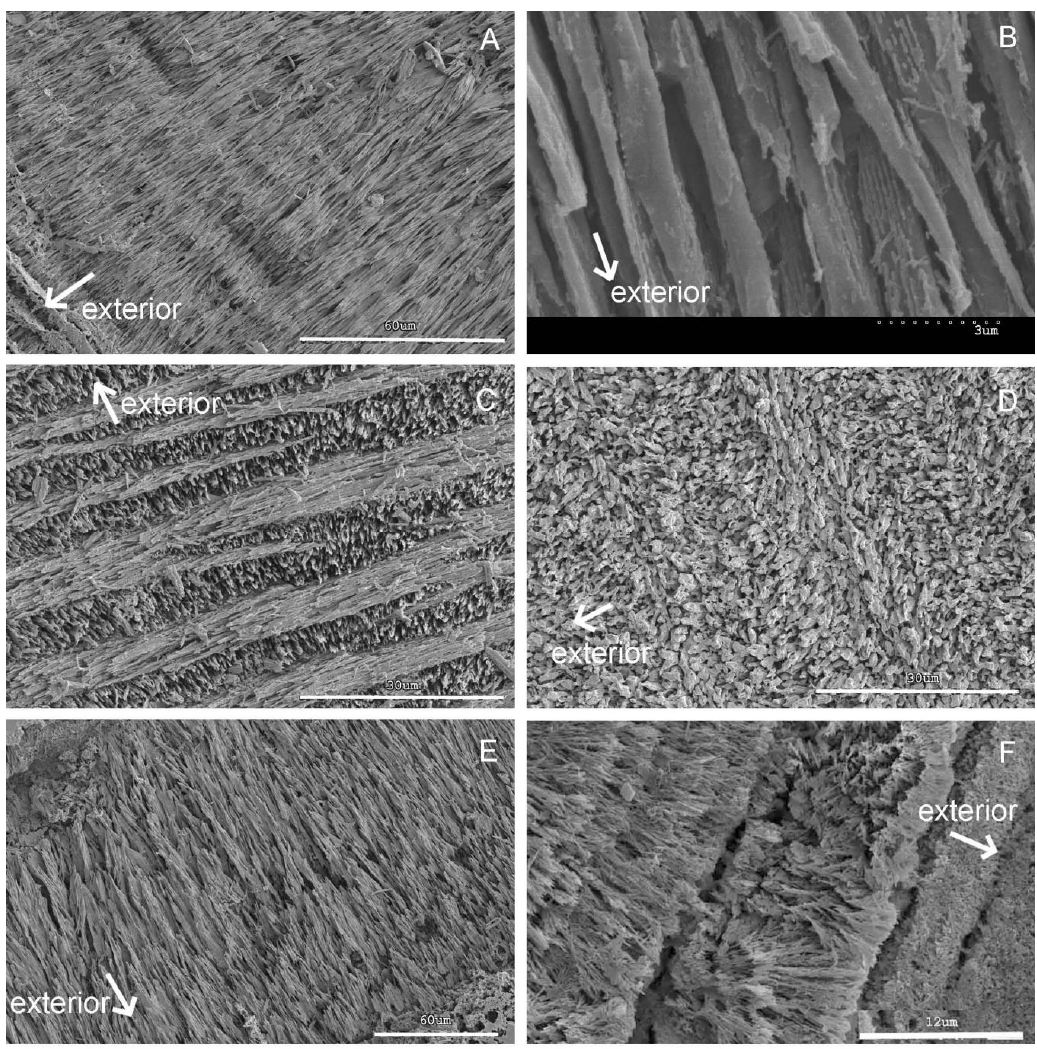
Figure 2. ( A ) Transverse section of irregular spherulitic prismatic structure in Pyrgopolon mellevillei from the Eocene of England. ( B ) Transverse section of regularly ridged prismatic structure (RRP) in Miocene D . gracillima. ( C ) Longitudinal section of twisted plywood structure in Spiraserpula sp. from the Miocene of Austria. ( D ) Longitudinal section of lamello-fibrillar structure in Rotularia nummularia (Eocene, Italy). ( E ) Longitudinal section of spherulitic prismatic structure in Glomerula sp. (Upper Cretaceous, Germany). ( F ) Longitudinal section of spherulitic prismatic structure in Diplochaetetes mexicanus from the Oligocene of